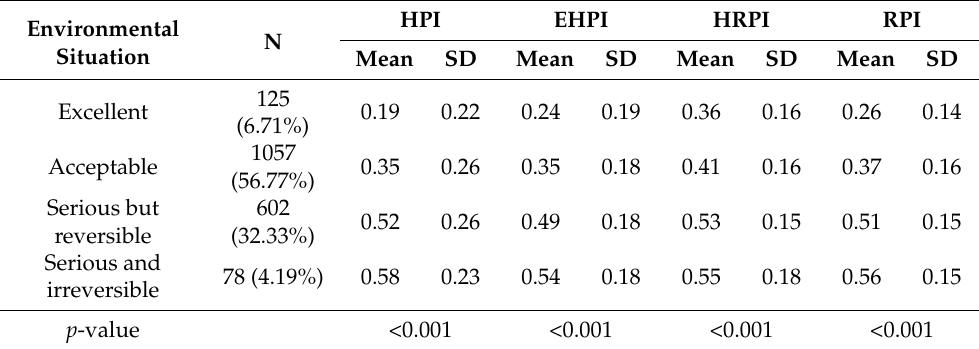
Table 7. Association among perception indices and question 12.5 “How do you judge the environ- mental situation of the municipality where you live in?”.